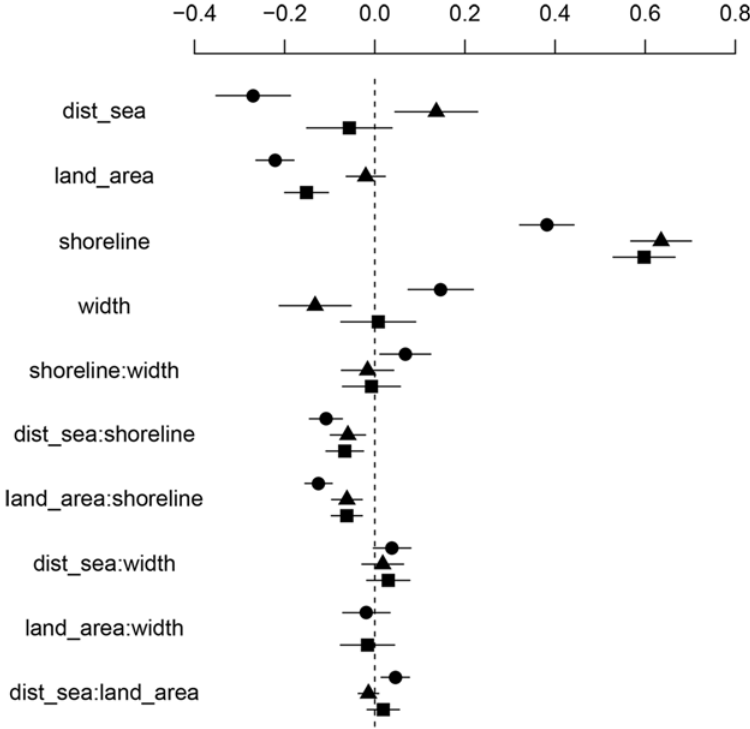
Fig 2. Parameter estimates and 95% confidence intervals for GLMMs for the different species groups. The number of specialist bird species per square (circles), the number of generalist bird species per square (triangles) and the total number of bird species per square (squares). The explanatory variables were the same in all three models, in the model for the generalists the interaction between land area and archipelago width was removed due to convergence problems. land_area = land area within each square; dist_sea = distance to open sea; shoreline = shoreline length; width = archipelago width. Interactions between variables are indicated by ‘ : ’ .